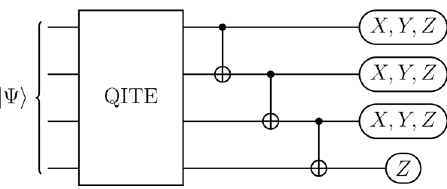
FIG. 4. Measurement of a Pauli string in a four-site QITE cal- culation with postselection on the stabilizer generator Z 0 Z 1 Z 2 Z 3 . The appended CNOT gates achieve simultaneous measurement of the Pauli string with the stabilizer generator by transforming Z 0 Z 1 Z 2 Z 3 to Z 3 acting on a single qubit, from which the